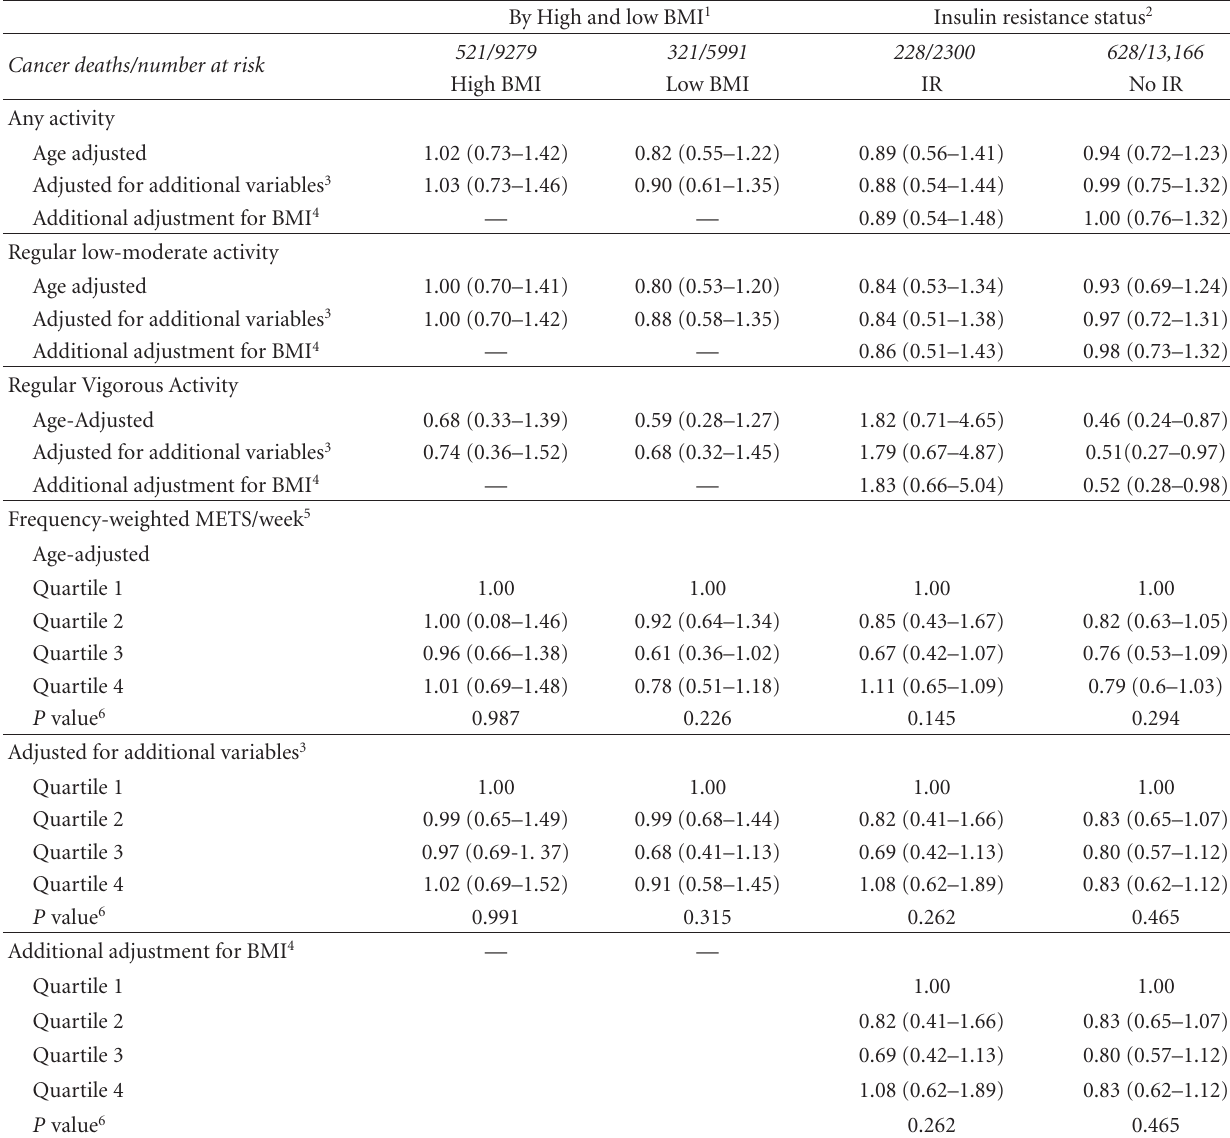
Table 3: Hazard ratio (HR) (95% CI) for cancer mortality and leisure-time physical activity in NHANES III (1988–1994) participants 20–89 years, by categories of body mass index and insulin resistance